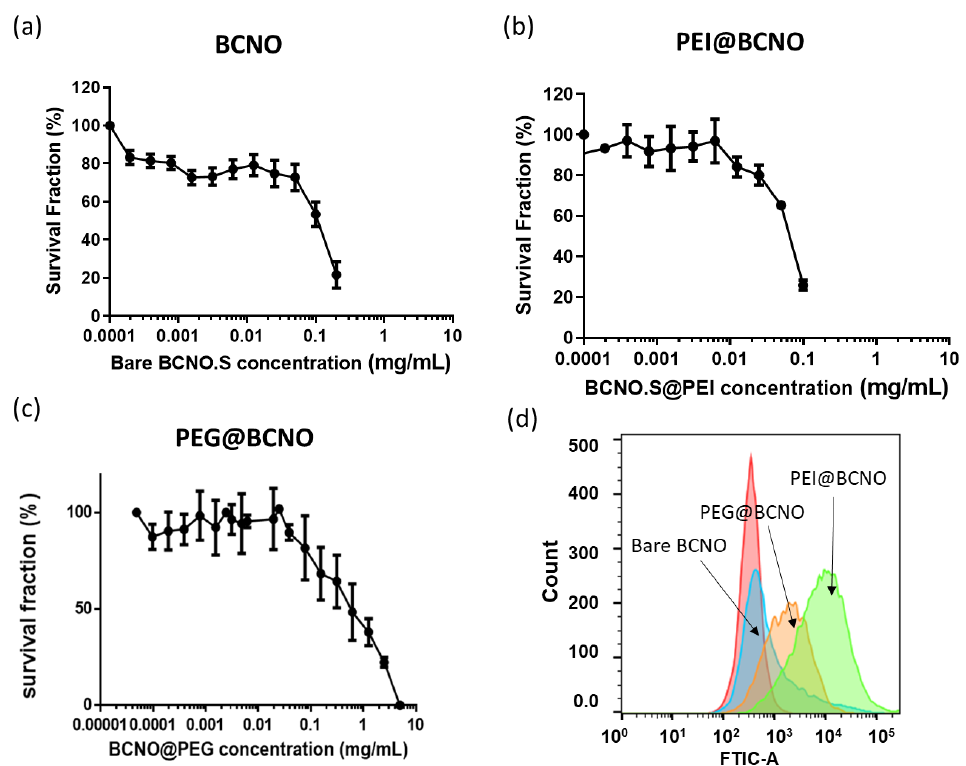
Figure 6. ( a ) MTT assay of BCNO on ALTS1C1 ( b ) MTT assay of PEI@BCNO on ALTS1C1 ( c ) MTT assay of PEG@BCNO on ALTS1C1 ( d ) flow cytometry of bare BCNO, PEI@BCNO and PEG@BCNO.